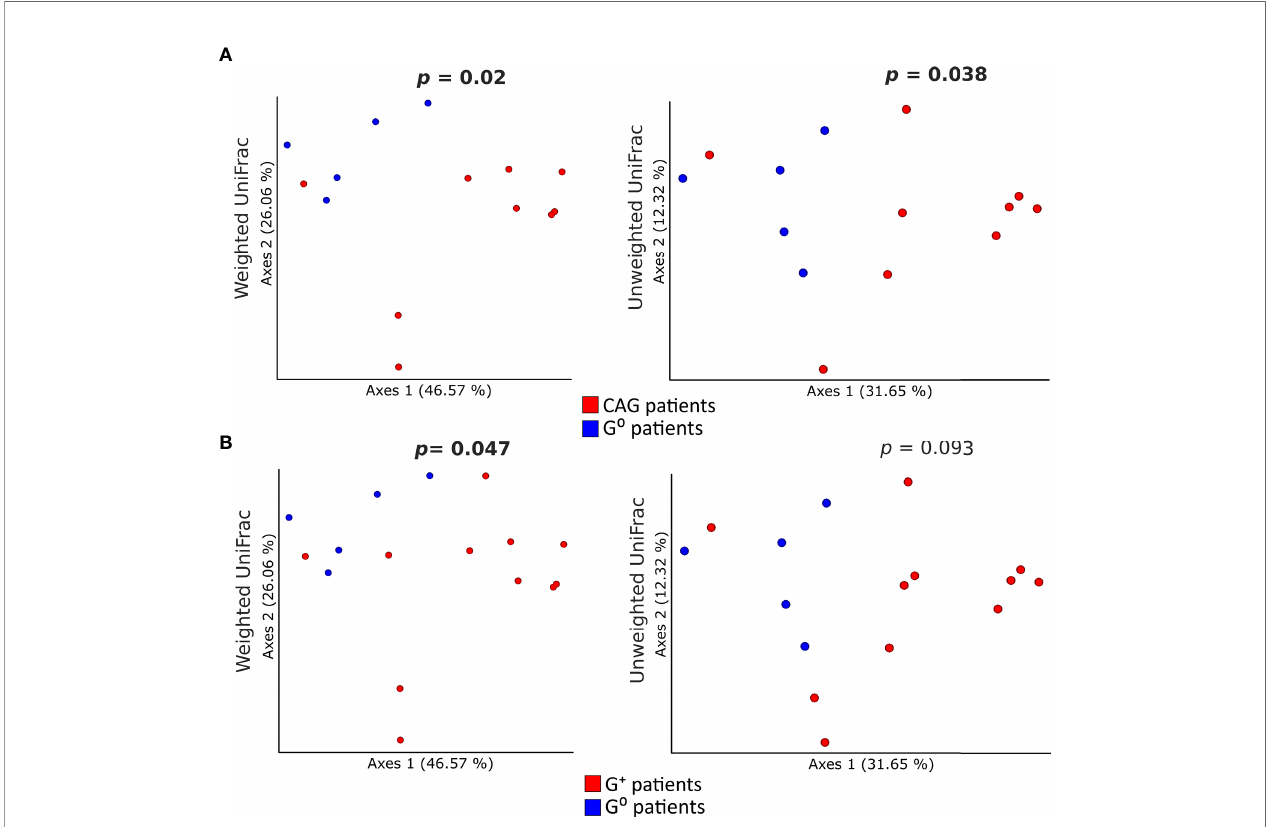
FIGURE 4 | Comparison of the beta-diversity of duodenal microbiota between CAG or G + patients, and G 0 patients. Principal coordinate analysis (PCoA) plots of weighted and unweighted UniFrac distances of the microbiota from duodenal biopsies of CAG (A) and G + patients (B) are illustrated. Each dot represents the bacterial community composition of one individual at each anatomical site. Groups were compared using Adonis for beta